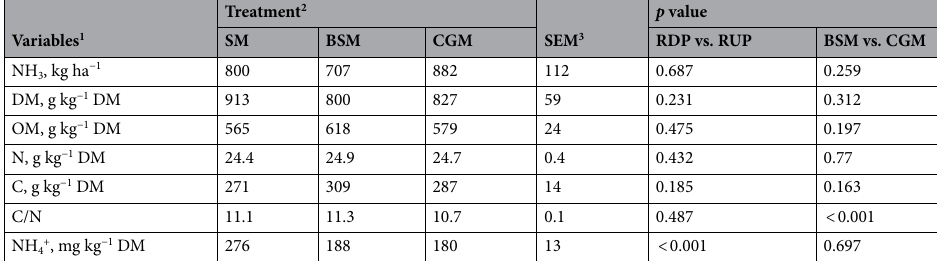
Table 6. Cumulative NH 3 emission and manure characteristics of Nellore cattle fed with sources of rumen undegradable protein during the finishing phase in feedlot. 1 NH 3 = accumulated values during 77 days of evaluation. DM = dry matter, OM = organic matter; 2 SM = manure of animals fed soybean meal as a source of rumen degradable protein (RDP), BSM = manure of animals fed by-pass soybean meal as a source of rumen undegradable protein (RUP), CGM = manure of animals fed corn gluten meal as a source of